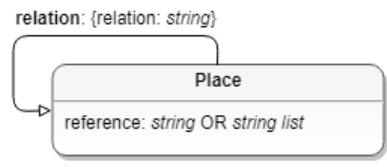
Figure 3. UML of the original place graph